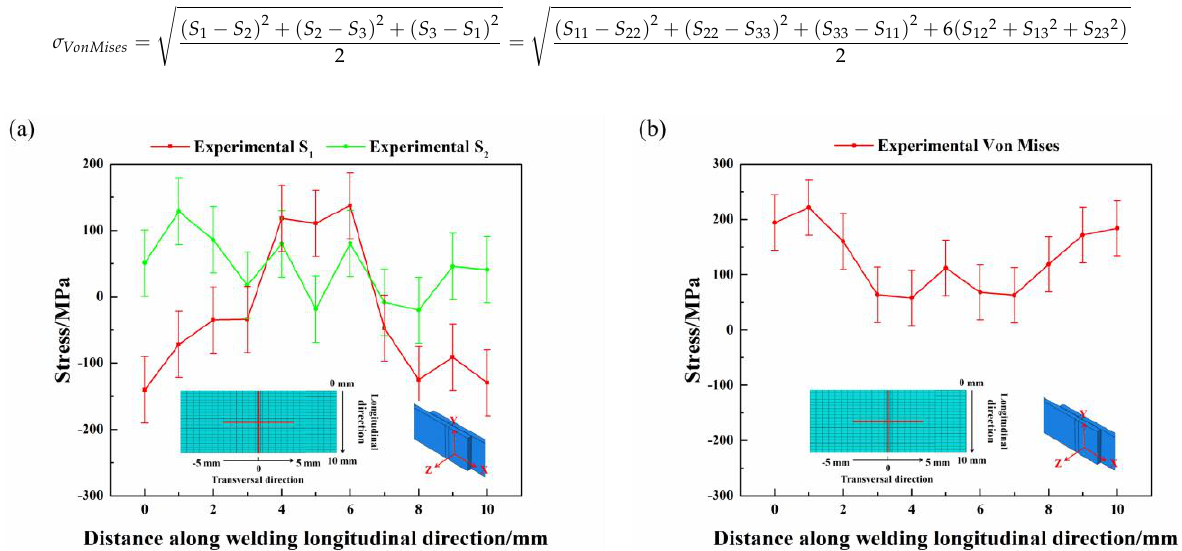
Figure 6. Low-cycle fatigue residual stress by neutron diffraction ( a ) S 1 and S 2 , ( b ) Von